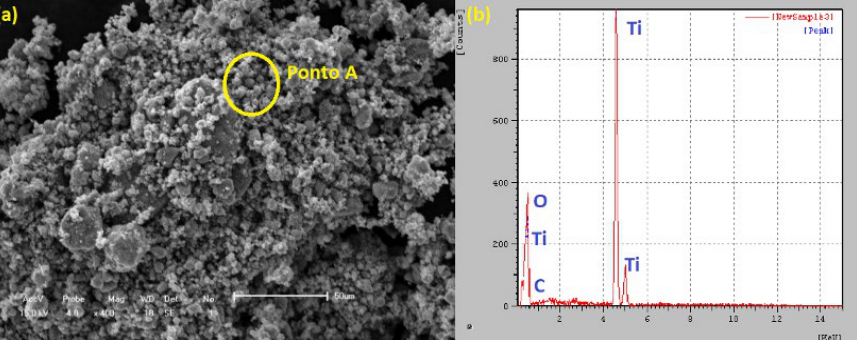
Figure 3 ( a) Image obtained by SEM of the TiO 2 powder; (b) EDS image of TiO 2